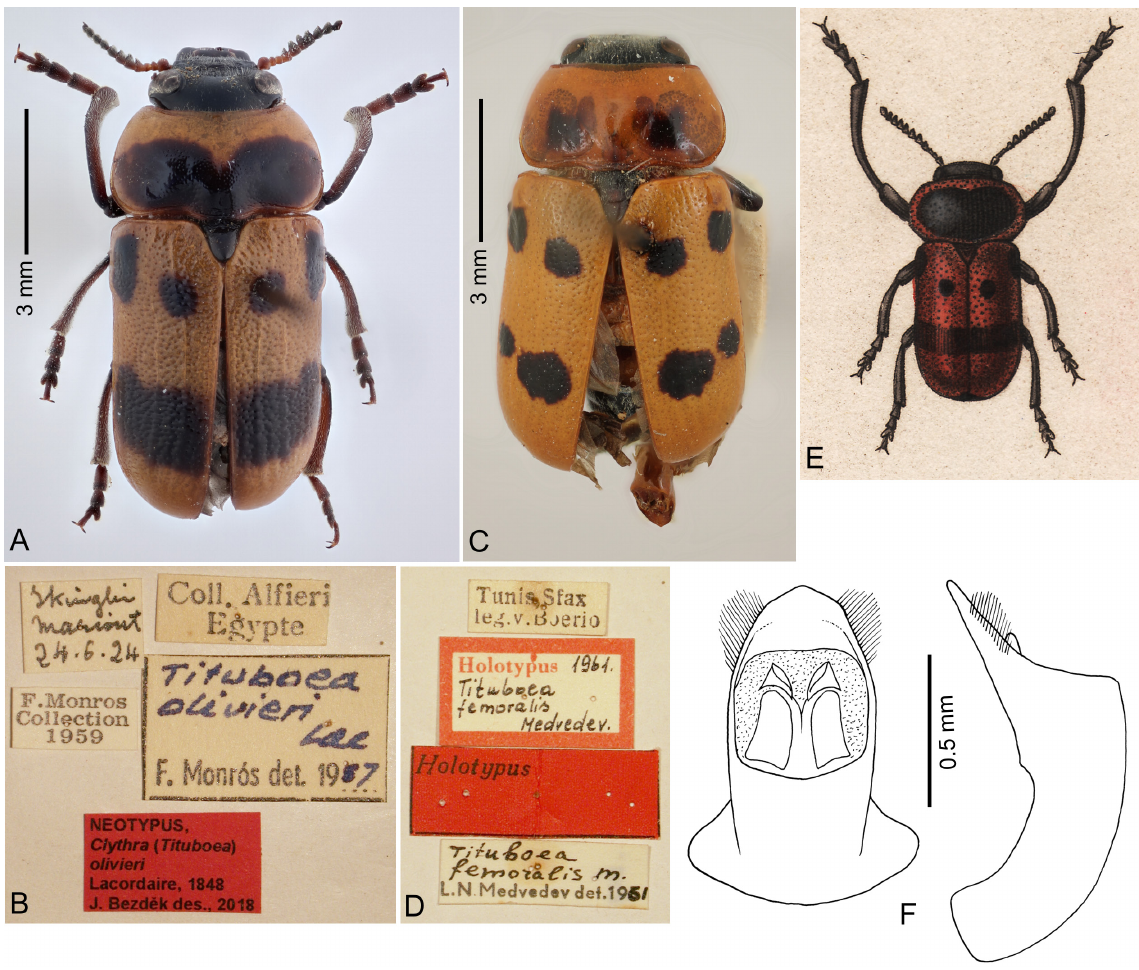
Fig. 8. Tituboea olivieri (Lacordaire, 1848). A – B . Neotype, ♂, 9.4 mm (USNM). A . Dorsal view. B . Labels. C – D . Holotype of T. femoralis Medvedev, 1962 (HNHM). C . Dorsal view. D . Labels. E . Drawing of T. olivieri from Lefèvre (1872). F . Aedeagus in dorsal and lateral views, ♂, Tunisia, Gabes